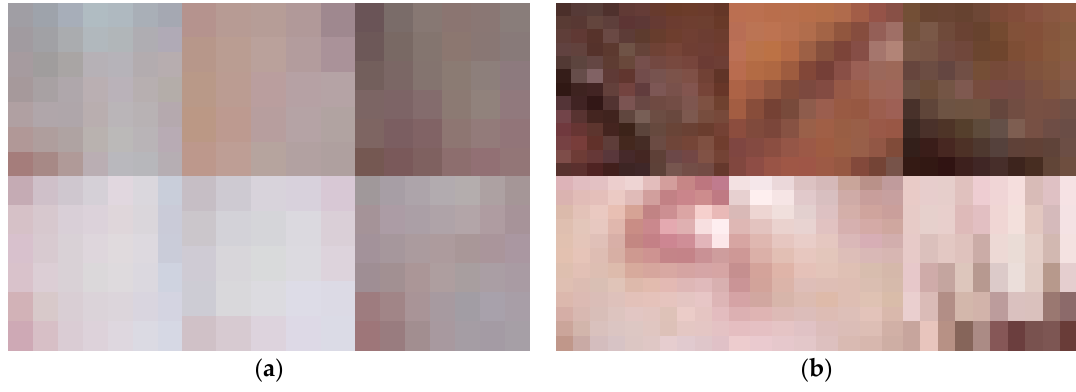
Figure 7. Sclera ( a ) and non-sclera ( b ) patches used to train the SVM classifier. The non-sclera patches are selected from the skin and eyelashes region.